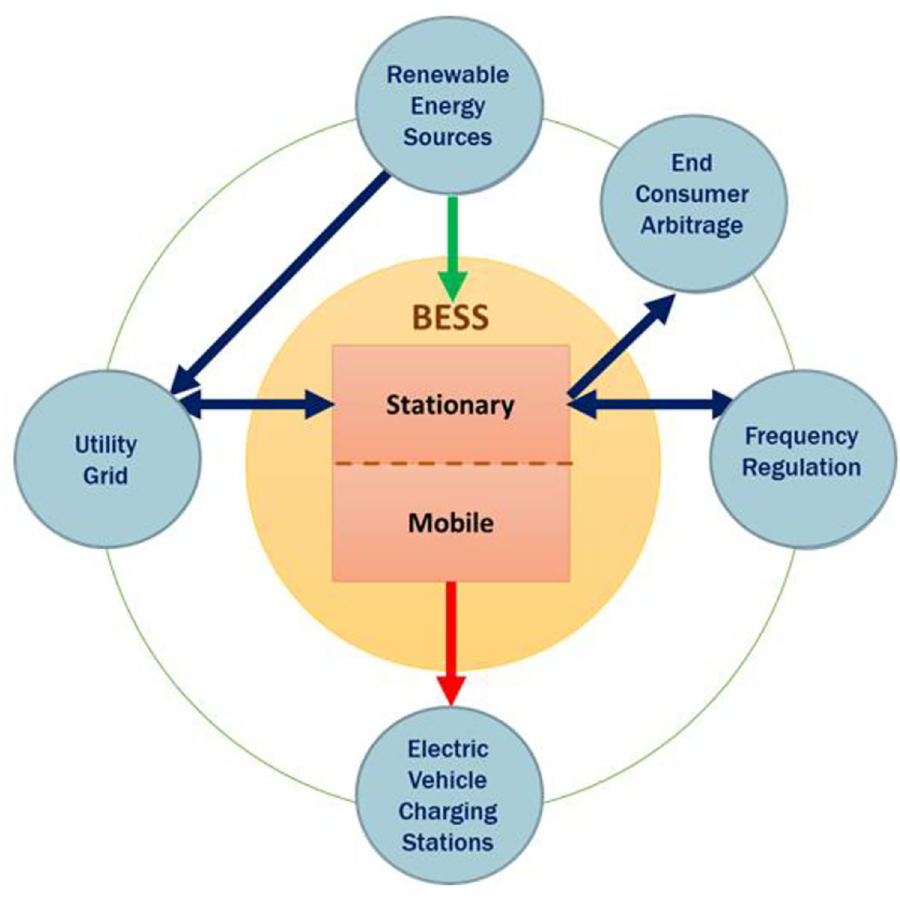
Fig 2. Diagram of the proposed